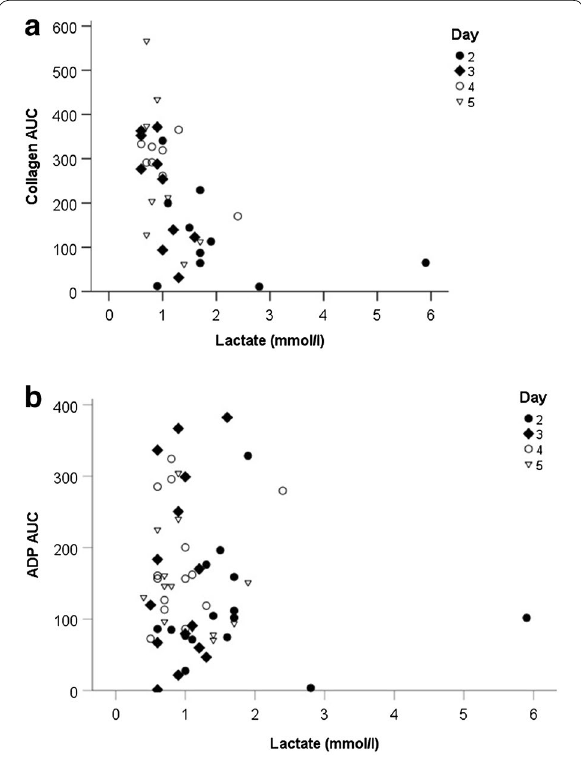
Fig. 5 Correlation of serum lactate levels with a collagen AUC. b ADP